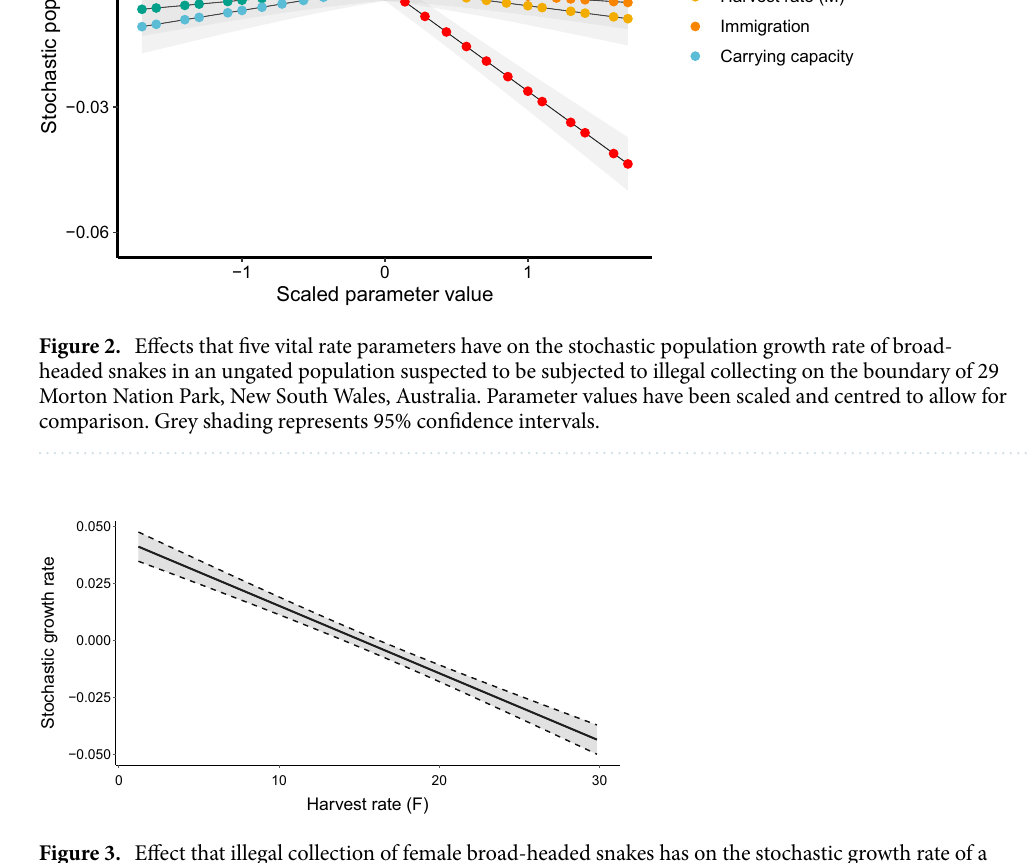
Figure 3. Effect that illegal collection of female broad-headed snakes has on the stochastic growth rate of a population suspected to be impacted by collecting on the boundary of Morton National Park, New South Wales,